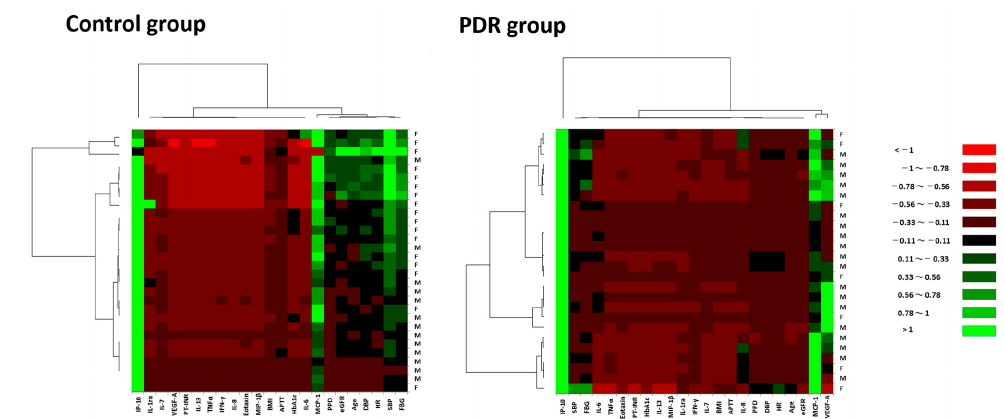
Figure 1. Hierarchical cluster analysis showing expression patterns of systemic factors and vitreous fluid cytokines in PDR patients and controls. Heat maps are composed of age, BMI, SBP, DBP, PPD, HR, PT-INR, APTT, RBG, HbA1c and eGFR as systemic factors; and vitreous fluid cytokines comprising IL-1ra, IL-6, IL-7, IL-8, IL-13, eotaxin, IFN- γ , IP-10, MCP-1, MIP-1 β , TNF α and VEGF-A. Color scale: low values, red; middle to high values, black to green. Vertical axis indicates gender of subjects, and horizontal axis shows explanatory variables. In the PDR group (Figure 1), the explanatory variables were roughly classified into single cytokine and two principal clusters as follows: (1) the single cytokine was IP-10; (2) one cluster consisted of two cytokines, MCP-1 and VEGF-A; and (3) another cluster was composed of all the systemic factors and the remaining cytokines. In summary, although MCP-1 and VEGF-A clustered independently with different systemic factors in control group, the two cytokines were altered in the PDR group, losing property similarity with